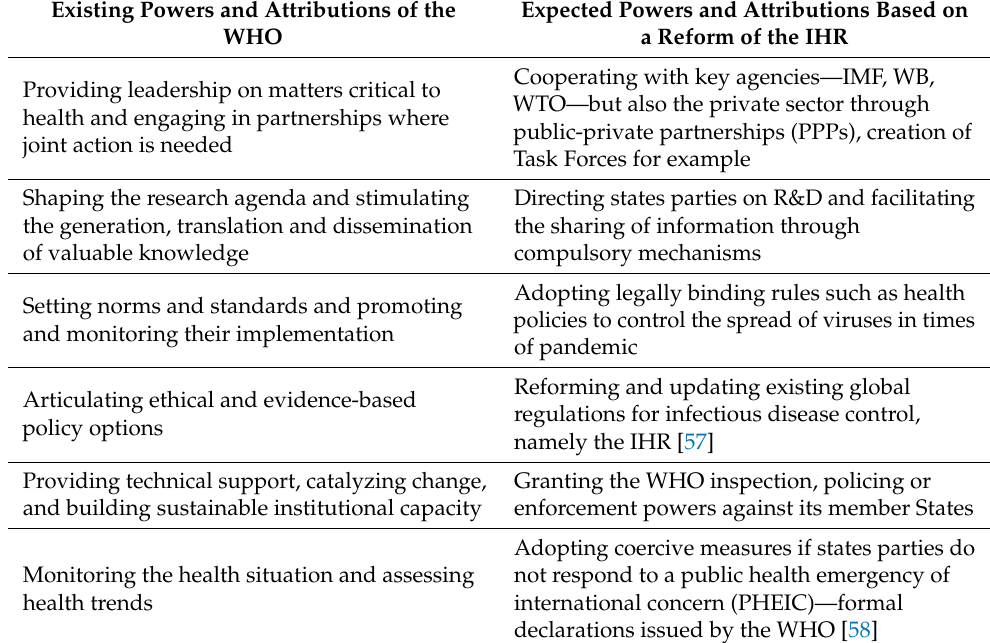
Table 4. WHO’s normative